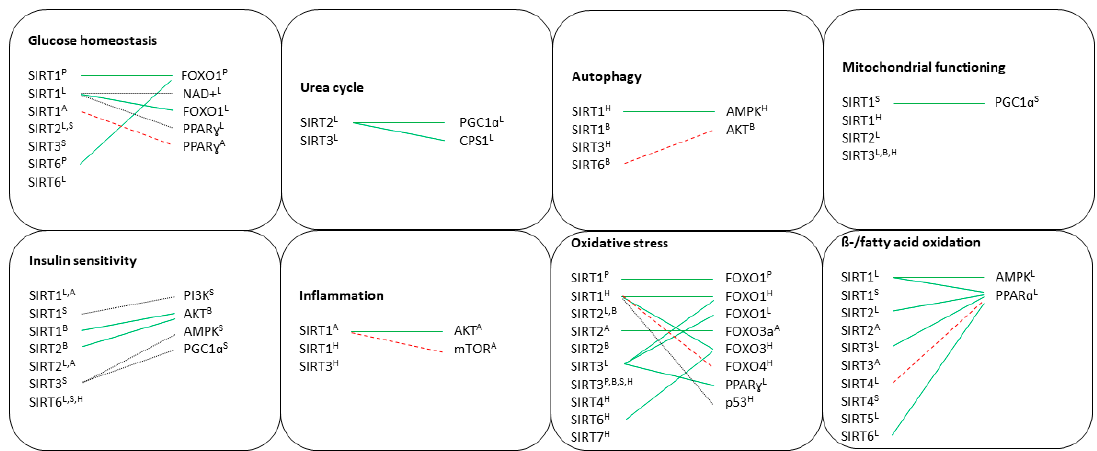
Figure 1. Metabolic processes where Sirtuins and their main targets are involved. GC1 α , PPAR α and AMPK are not indicated because activators, and not targets, of Sirtuins: GC1 α and PPAR α upregulate SIRT5 levels, whereas AMPK downregulates SIRT5 levels. Green lines, activatory interactions; red lines, inhibitory interactions; black lines, unspecified interactions. P, pancreas; L, liver; B, brain; A, adipose tissue; S, skeletal muscle; H, heart.